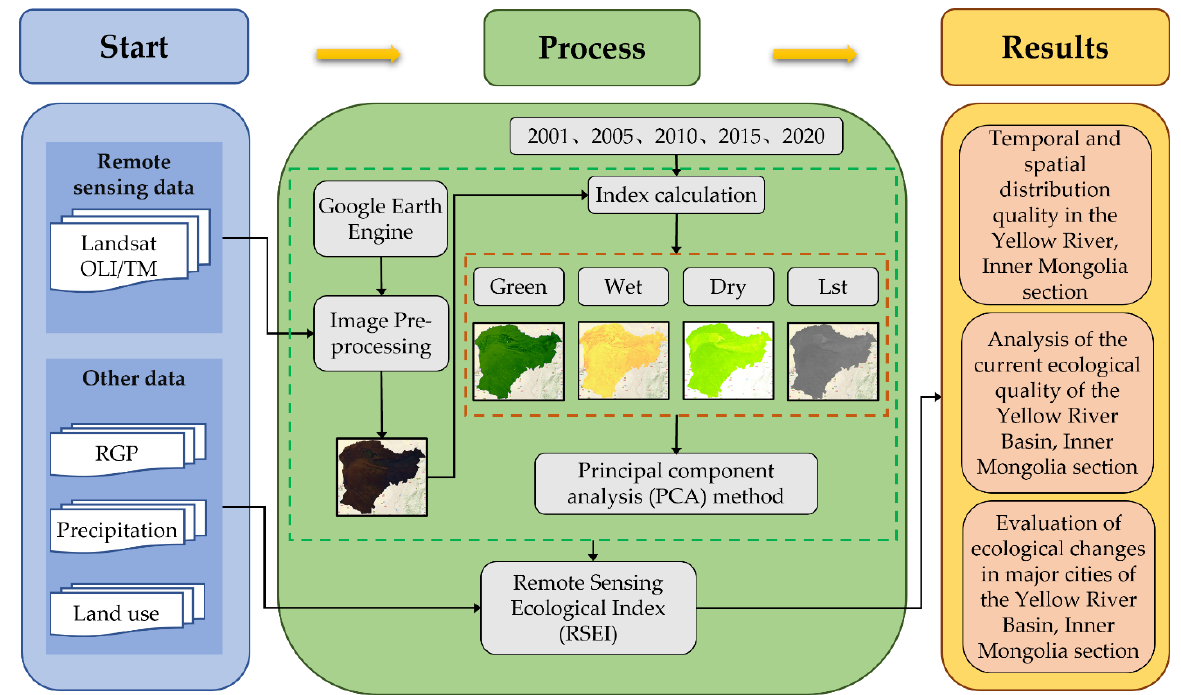
Figure 2. Flow chart showing the ecological quality in the Yellow River, Inner Mongolia section.